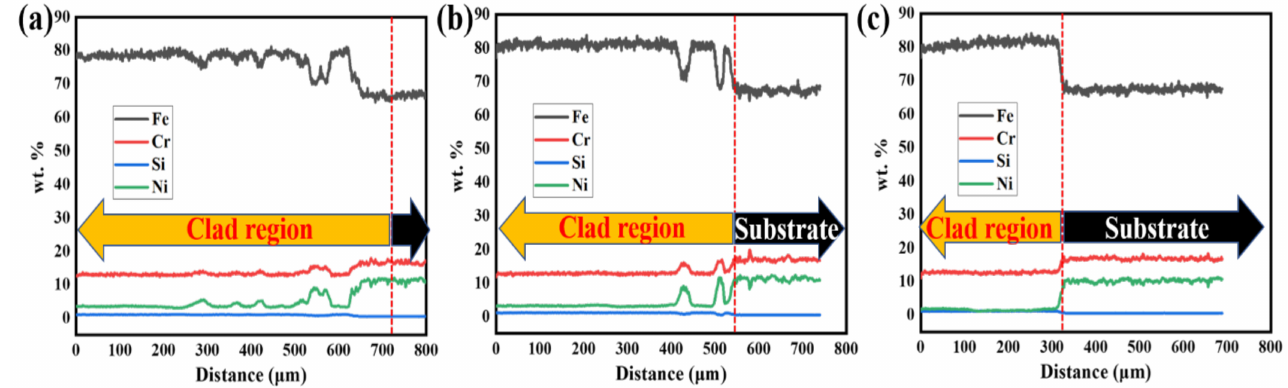
Figure 4. Component behavior of Fe-Cr-Si single-line clads at various laser traverse speeds: ( a ) 12 mm/s, ( b ) 14 mm/s, and ( c ) 16